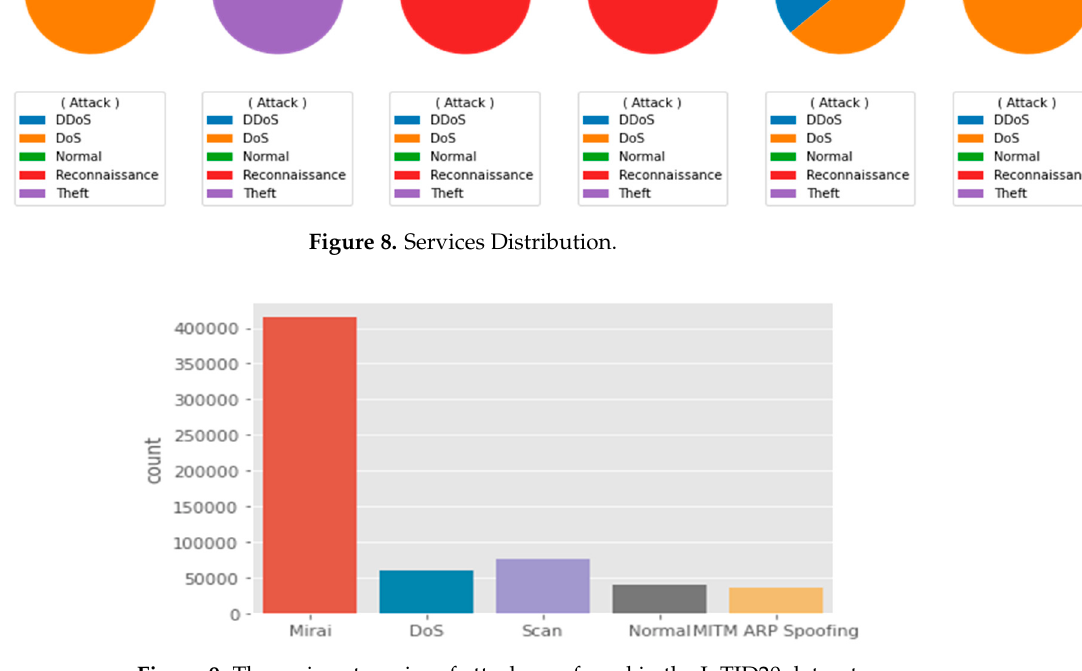
Figure 8. Services Distribution.